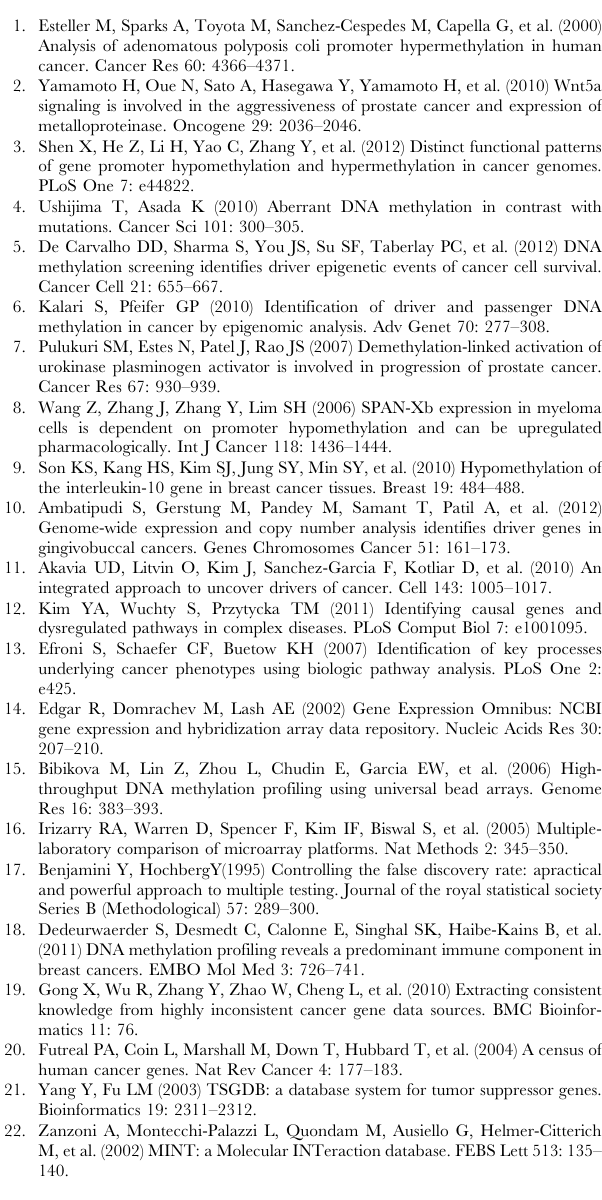
Table S1 Cancer-associated pathways. List of 37 cancer- associated pathways from KEGG and the literatures. Table S2 Driver genes in three breast cancer datasets. List of 249, 205 and 62 driver methylation loci identified from Bre100, Bre95 and Bre60 datasets, respectively with the cancer-associated pathways significantly enriched with corresponding downstream genes (0, false;1,